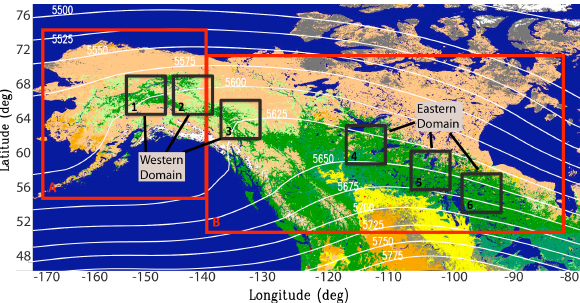
Figure 1. Fig. 1. Global MODIS derived ecosystem map. Red boxes delin- eate the large study regions for Alaska (A) and Canada (B) . The black boxes delineate the small boreal forest regions (1–6) defined for focused analysis in this study and the combination of regions 1–3 (4–6) is referred as the western (eastern) domain in the main text. Dark green areas comprise the dense evergreen needle leaf forest common in boreal regions, the tan shaded area is open tundra shrub-land, yellow is croplands, and orange is grassland. The white contours indicate the mean 500hPa geopotential height field for the fire season (June–August) for 2000–2006.